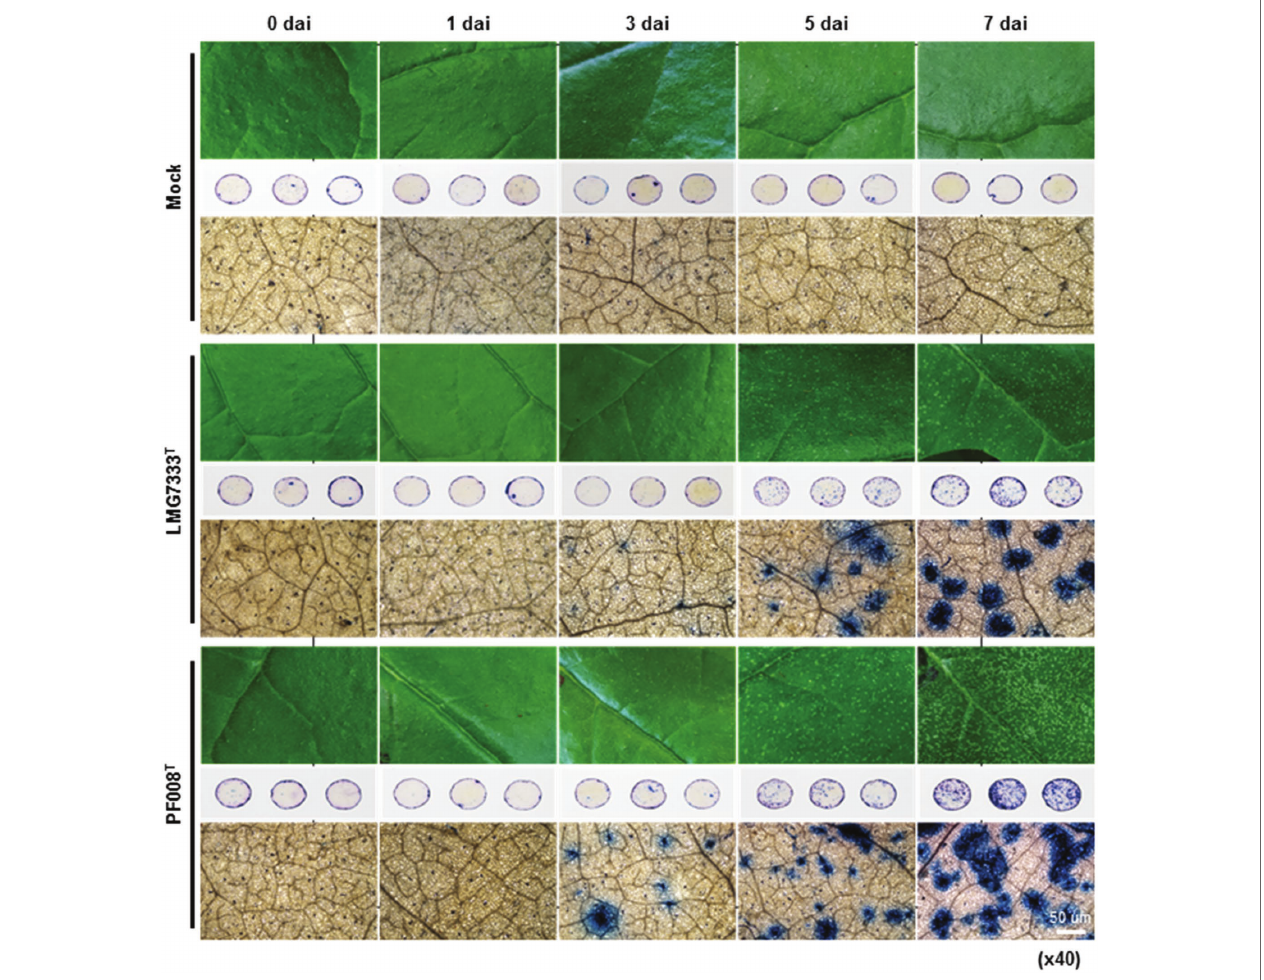
FIGURE 2 | Trypan blue staining of N . benthamiana leaves showing blister-like symptoms, after infiltration with 5×10 4 CFU/ml bacterial suspensions of C . michiganensis LMG7333 T and C . capsici PF008 T . Three-leaf disks (1 cm in diameter) per treatment were collected for trypan blue staining at 0, 1, 3, 5, and 7 days after inoculation (dai). Stained leaf disks were observed using an optical microscope at magnification x40. Sterilized distilled water was used for mock treatment. Scale bar = 50